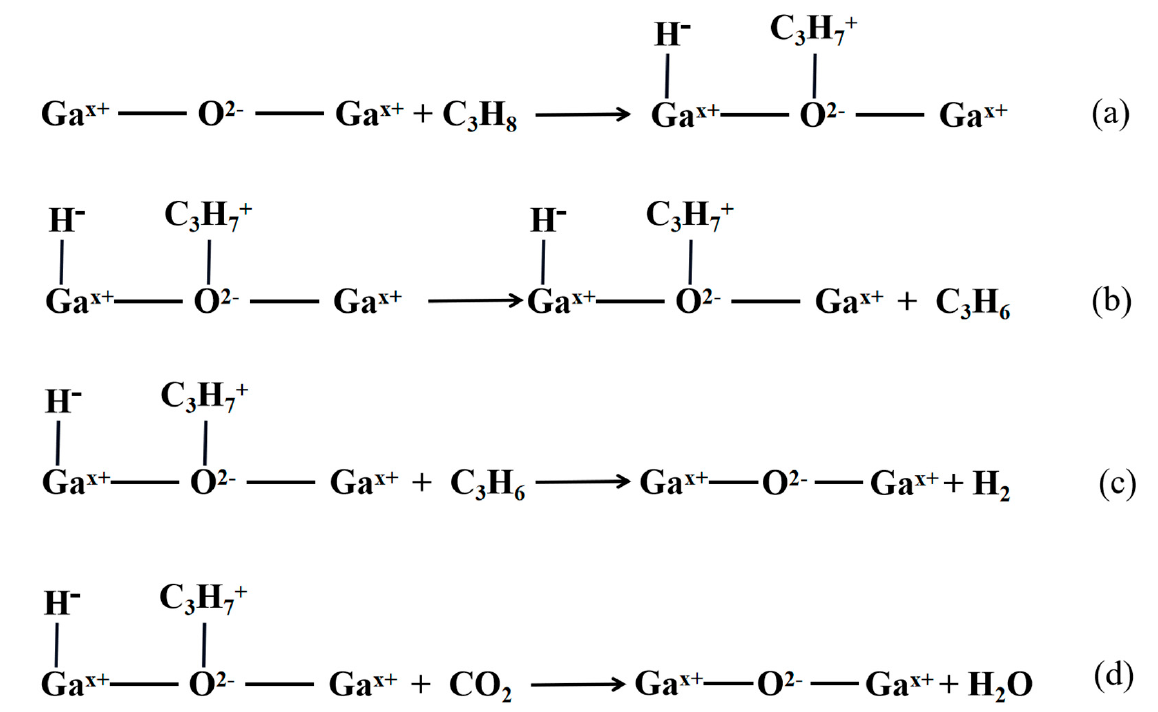
Figure 3. Reaction mechanism diagram of Ga 2 O 3 catalyst with propane ( a – d ).